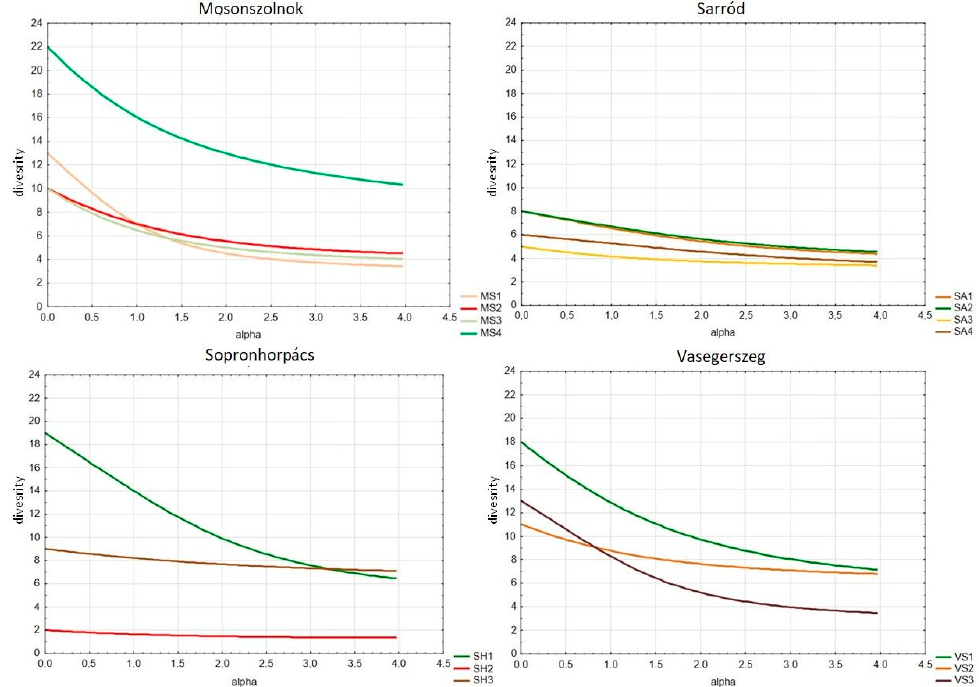
Figure 2. Diversity profiles of herbaceous plants in the examined shelterbelts in Mosonszolnok, Sarród, Sopronhorpács, and Vasegerszeg.